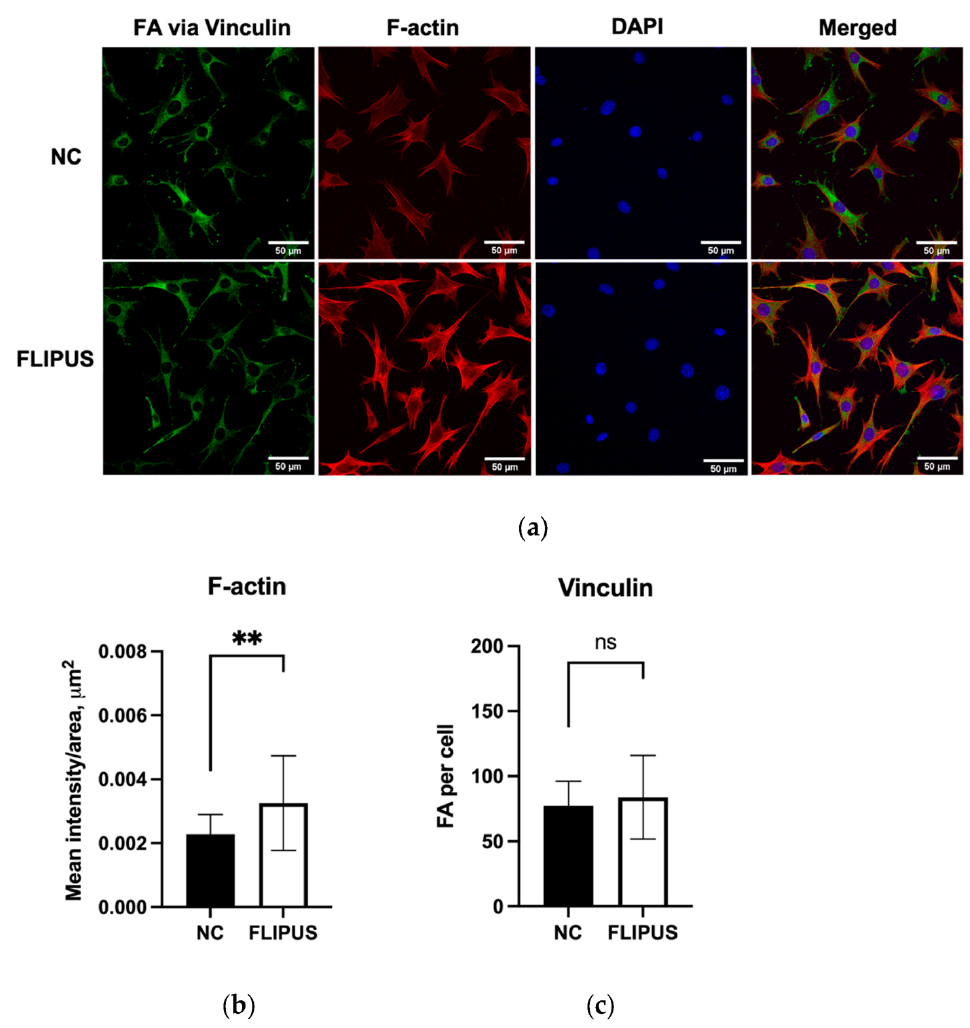
Figure 7. Cytoskeleton changes after the 10 min FLIPUS treatment of starved MLO - Y4 osteocytes . ( a ) Representative images of vinculin, F - actin and nuclei staining; ( b ) Quantification results of mean intensity values per cell area; ( c ) Quantification results of focal adhesions (FA) visualized by vinculin staining. Each data point was the result of N = 3, n = 2, where N and n are biological trials and technical replicates, respectively. Five random pictures were analyzed for each data point. ** repre- sents p ≤ 0.01.